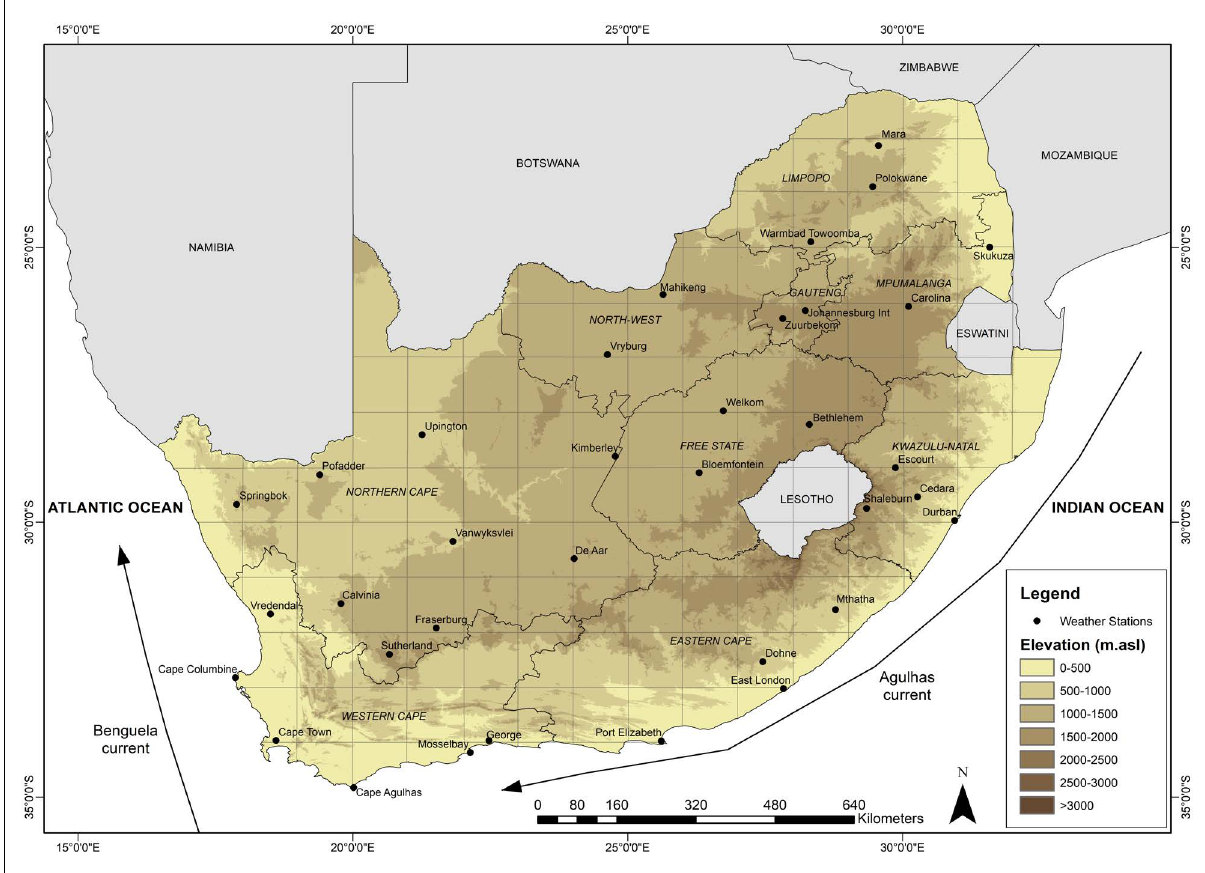
Figure 1: Map of the study region of South Africa, indicating 1° intervals used to select the meteorological stations across South Africa, the topography, the surrounding oceans and their respective ocean currents. been found that IDW interpolates station data accurately. 51 Additionally, annual mean graphs were produced for each of the temperature